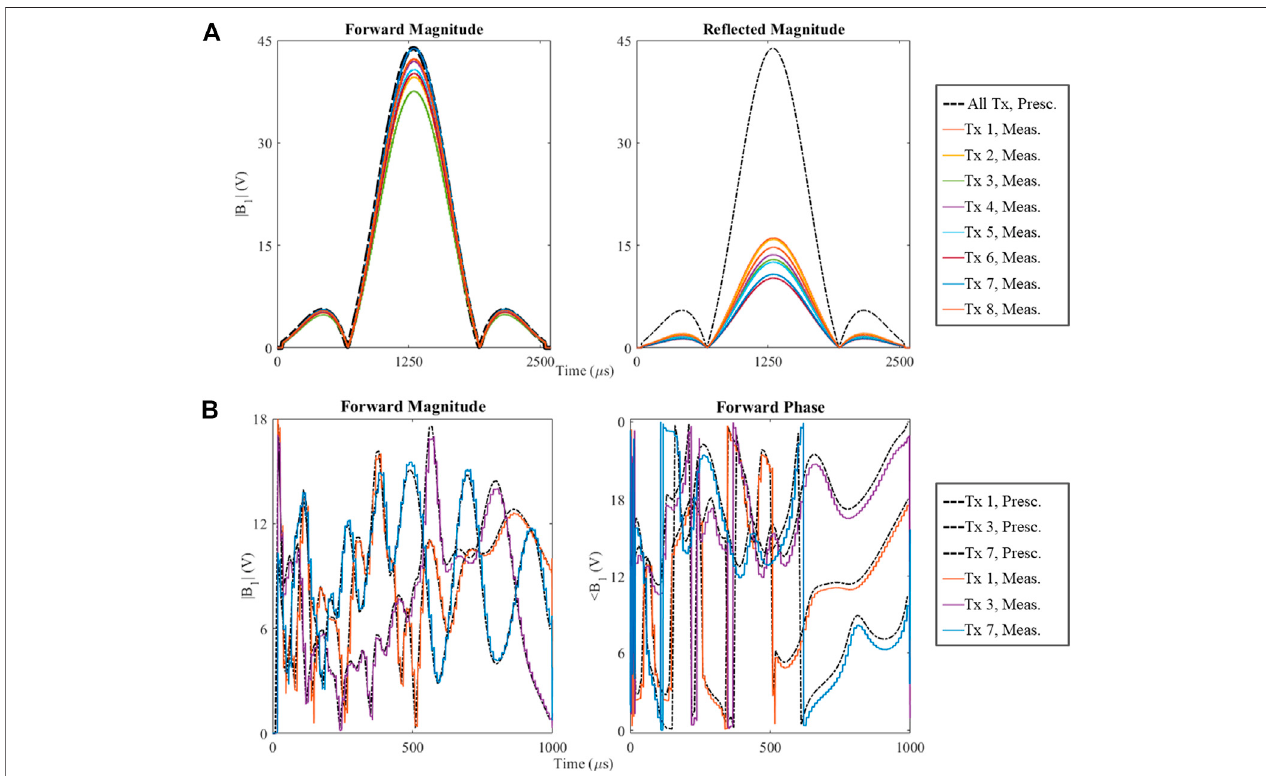
FIGURE 10 | Comparison of prescribed RF waveforms (black, dotted lines) and their measurements single transmit channels (solid, colored lines). (A) A conventional, circularly polarized, slice-selective SLR pulse with nominal fl ip angle of 90 ° , the left plot contains the forward measurement and the right plot contains the re fl ected measurement; (B) Dynamic,non-selectiveUniversalPulsepulsewithnominal fl ipangle of5 ° , theleft plotshowstheRFmagnitudewaveformsand theright plot shows RF phase waveforms for 3 out of 8 pTx